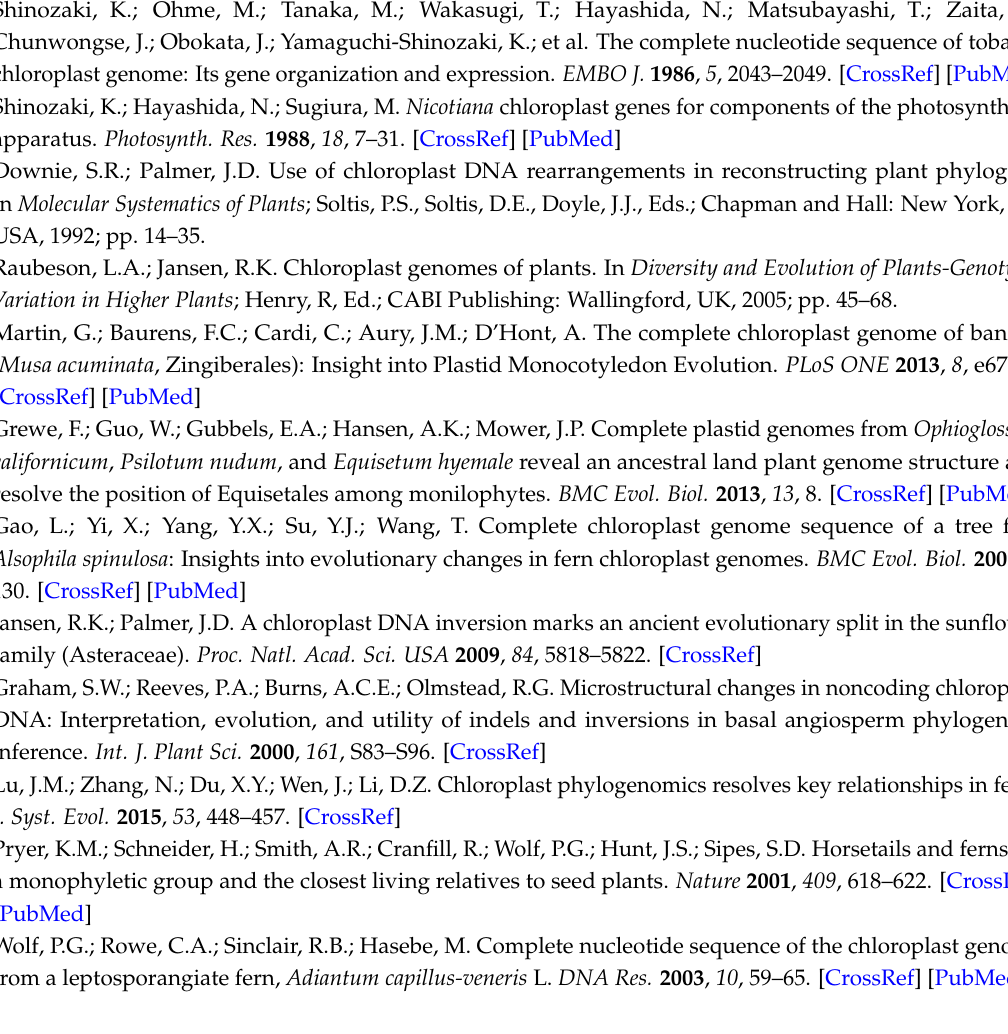
Table S1: Accession numbers of the chloroplast genome sequences used in this study, Table S2: List of identified simple sequence repeats of Cyrtomium falcatum chloroplast genome, Table S3: Distribution of hexa-, 7-, 8-, 9-, 10-, 12-, 13-, 14-, 17-, and 24-nucleotide single sequence repeats (SSRs) in Cyrtomium falcatum chloroplast genome. Acknowledgments: This study was supported by a National Research Foundation of Korea (KRF) grant funded by the Korean Government (KRF, No. 2012R1A1A2004996), South Korea and the Research Center for Policy Suggestion of the Ministry of Educational Science